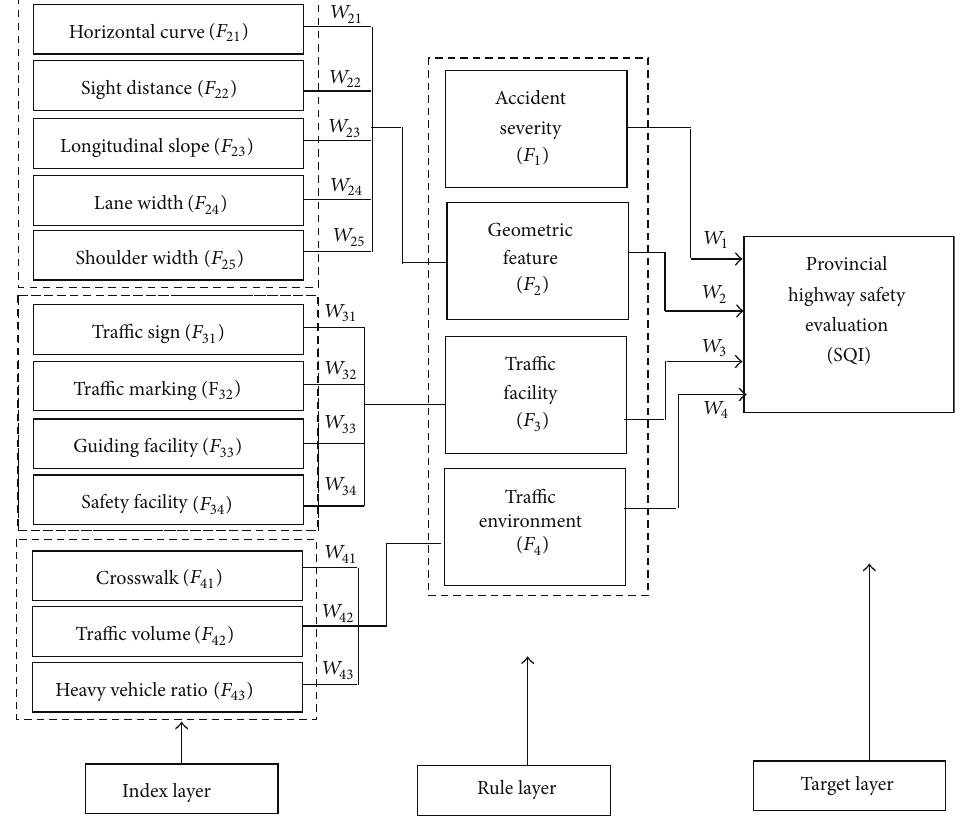
Figure 6: Logic structure for provincial highway safety